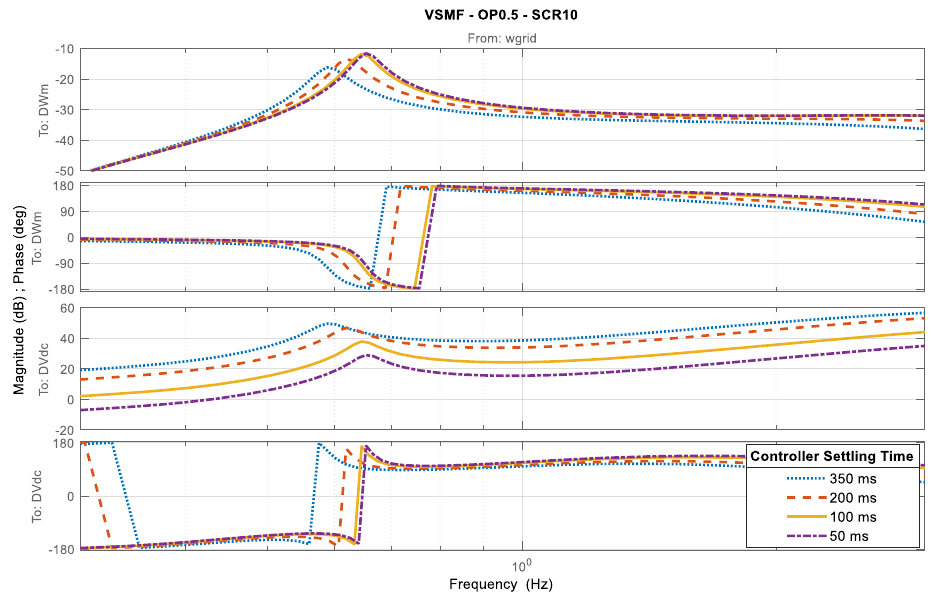
Figure 18. Bode plots comparing the generator-side DC link voltage controller tunings.